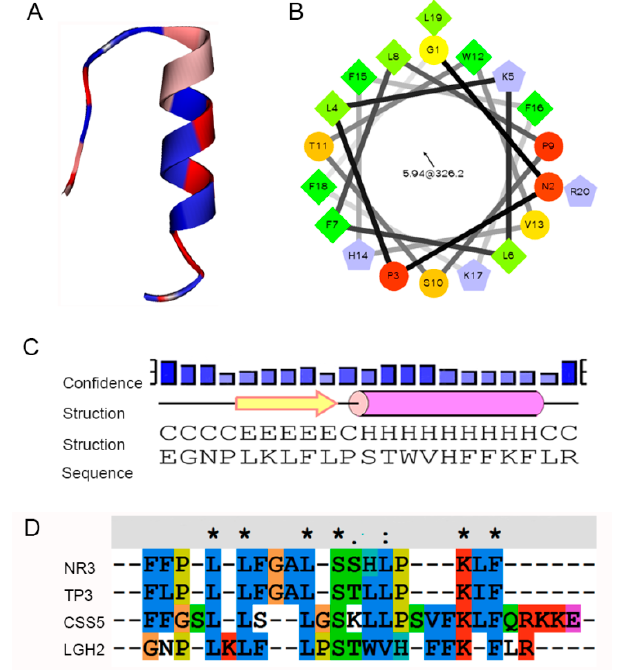
Figure 10. Bioinformatics analysis of LGH2. ( A ) Secondary structure of LGH2 ( B ) Helical wheel diagram for LGH2. ( C ) Secondary structure confidence analysis. ( D ) Multiple sequence alignment of LGH2 and its homologues by BLAST.